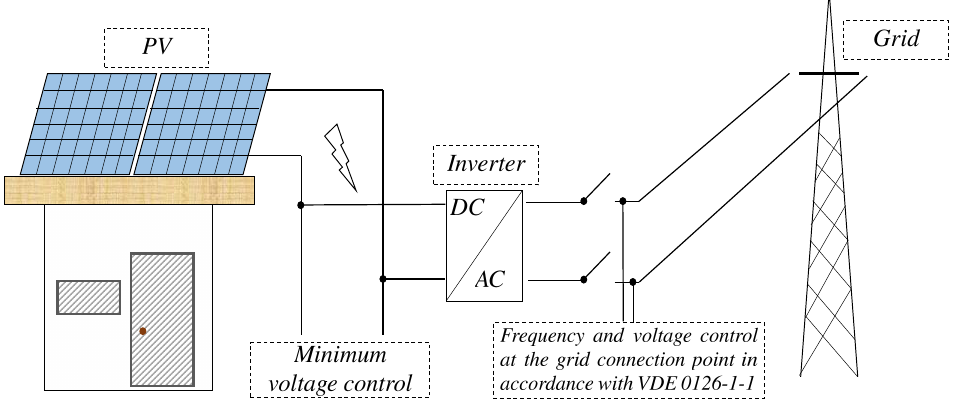
Figure 4. General connection scheme for grid connected photovoltaic (PV)